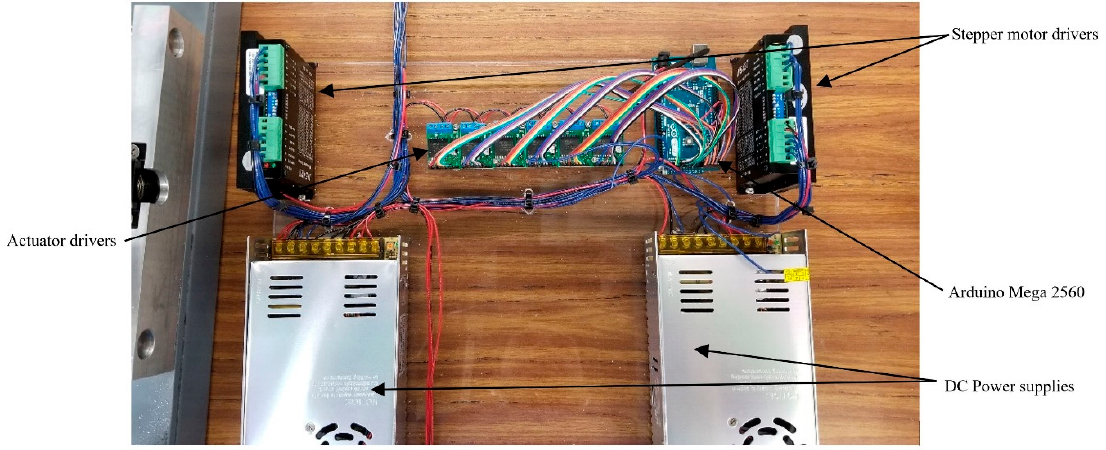
Figure 8. Control hardware preliminary assembly.